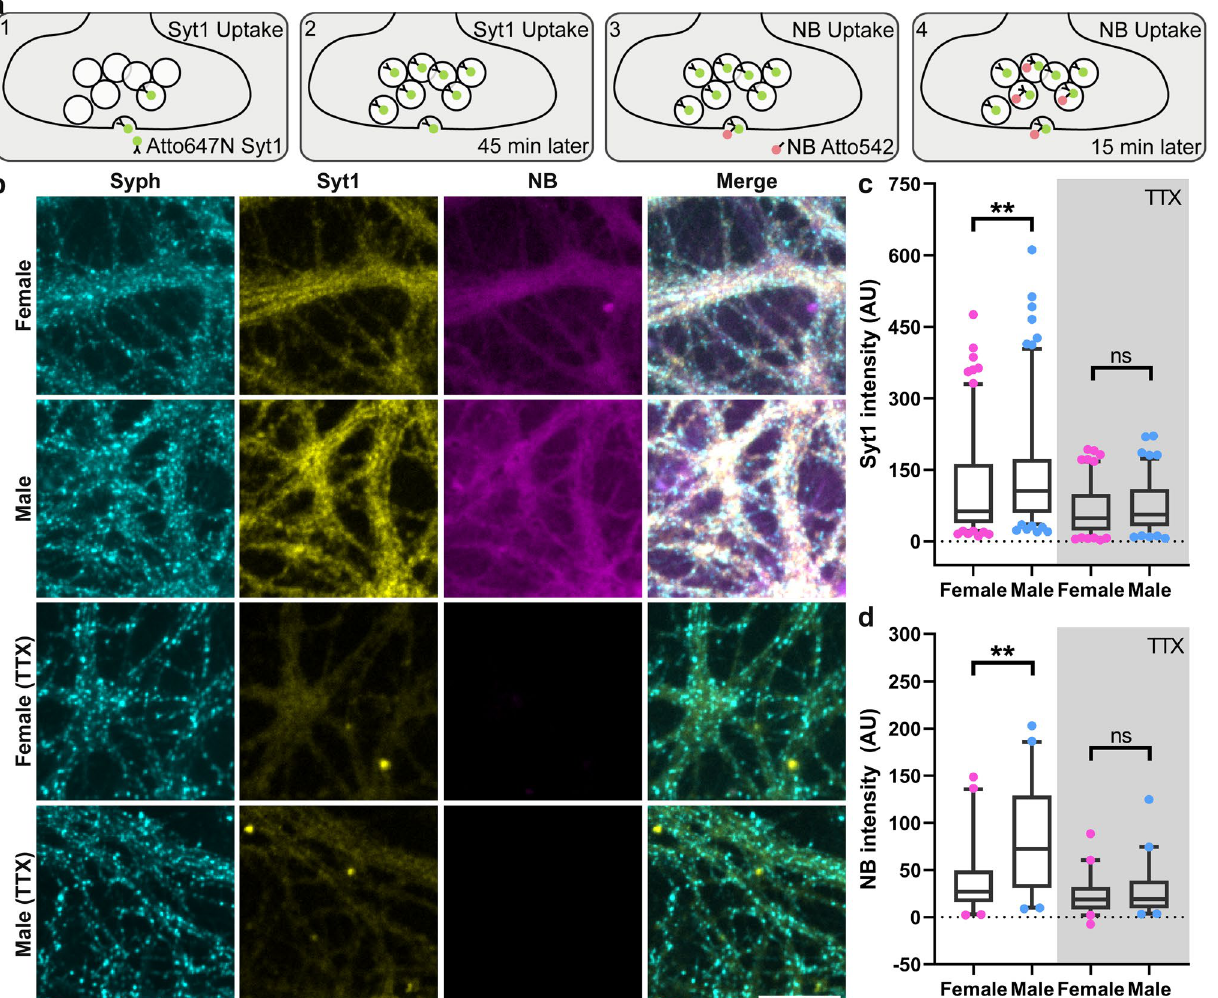
Figure 1. Male hippocampal neurons have a higher synaptic activity. ( a ) To study synaptic activity, we incubated the neurons for 45 min with an Atto647N-conjugated synaptotagmin 1 (Syt1) antibody (1). The intravesicular domain of Syt1 was detected by the antibody during the synaptic vesicle recycling (2). To estimate synaptic activity, we then added secondary nanobodies (NB), which detect the Syt1, and incubated for 15 min (3). The NB labeled vesicles represents the synaptic activity level during the respective 15 min (4). The cultures were immunostained for a synaptic marker (Syph) To label only the surface epitopes 12 , we stopped action potential generation with a tetrodotoxin (TTX) treatment. ( b ) Exemplary images of female and male neurons, including the TTX treatment. Scale bar: 50 µm. (c) To compare the recycling vesicle pool sizes in male and female neurons, we measured the intensity of the Syt1 antibody in Syph positive areas. The box plots show the first and third quartiles, as well as the median of the distribution. The whiskers indicate the 5–95 percentile. The shown symbols are the outliers. Each symbol represents the value measured from a whole Syt1 image. The statistical comparison between the two sexes was performed by the Kruskal–Wallis test together with the Dunn’s multiple comparisons test. **p < 0.01. N = 7 independent experiments, with 5 images taken for each experiment. (d) To compare the synaptic activity, we measured the NB intensity in the presynaptic area. The box plots and symbols are similar to those in panel c. **p < 0.01. N = 4 independent experiments, with 5 images taken for each